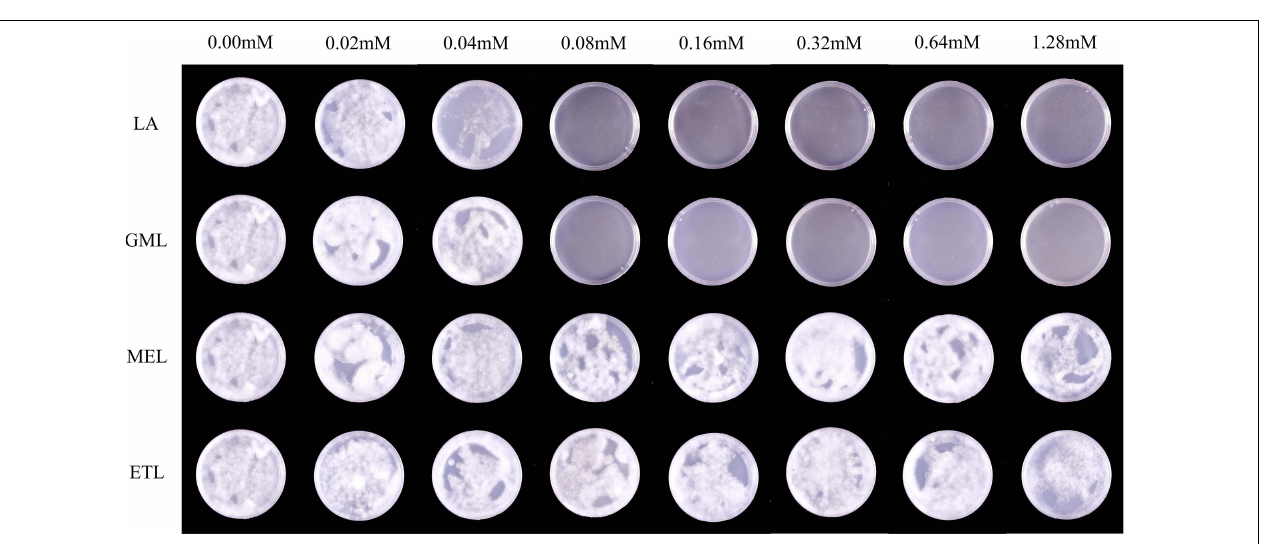
FIGURE 4 | The effects of LA and its derivatives on P. sojae zoospore germination. To observe zoospore germination, zoospore suspensions were smeared on V8 medium containing LA, GML, MEL, or ETL at different concentrations. The experiment was repeated three times with similar results. Means with different letters are significantly different (Statistical Product and Service Solutions (SPSS), p <